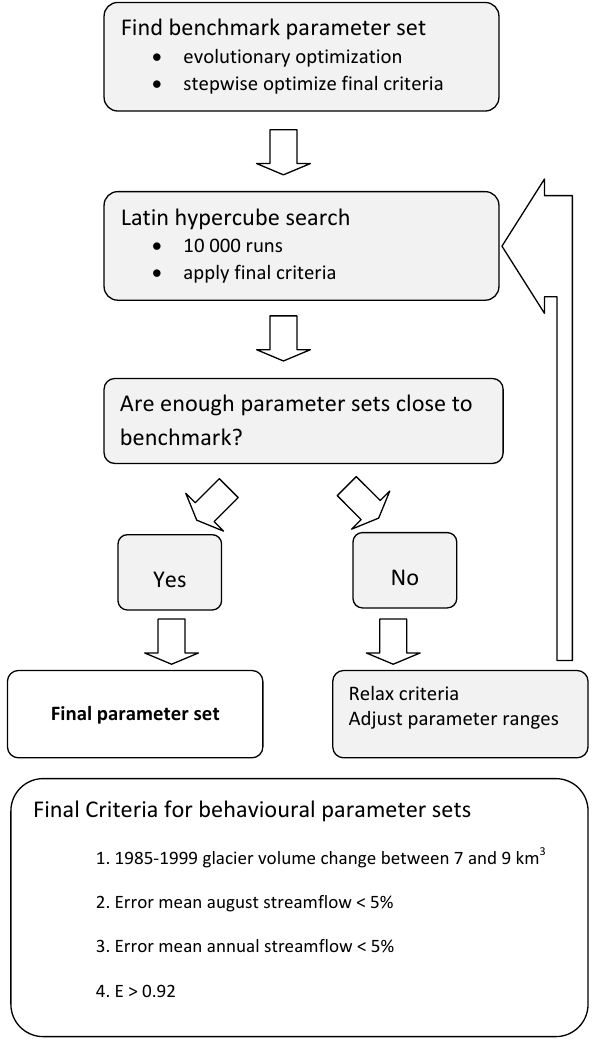
Fig. 2. Flow chart illustrating the “guided” GLUE approach for cal- ibration and uncertainty analysis. E is the Nash-Sutcliffe efficiency.